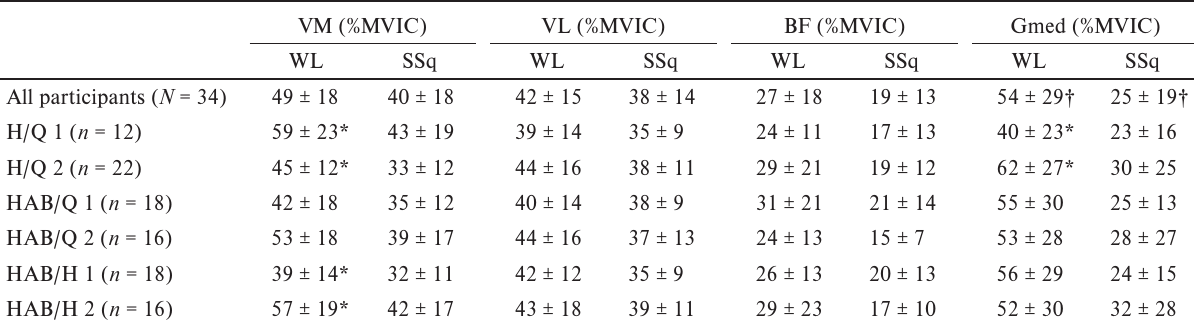
EMG results by groups expressed as means and standard deviations